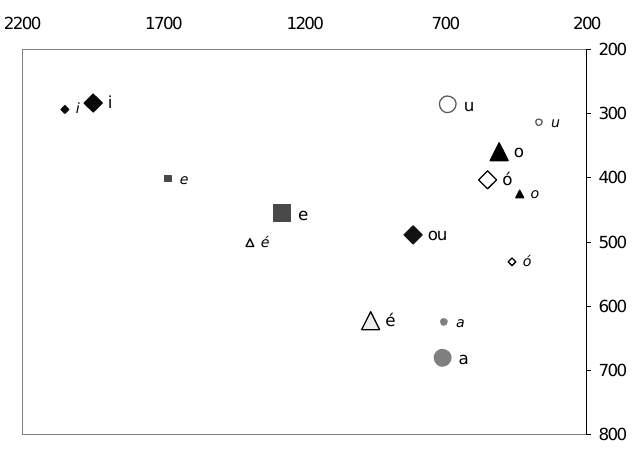
Figure 7: The Vowel Space of Speaker L.